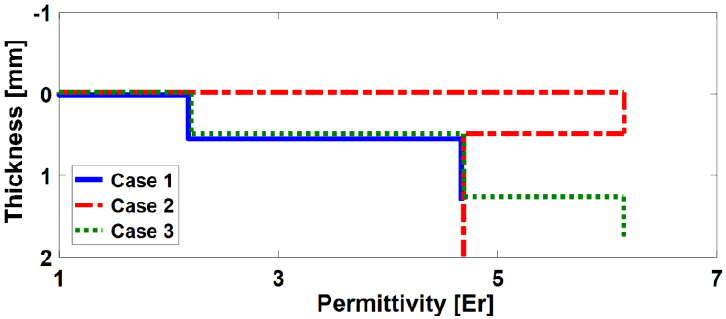
Figure 3. Estimated values of model parameters.